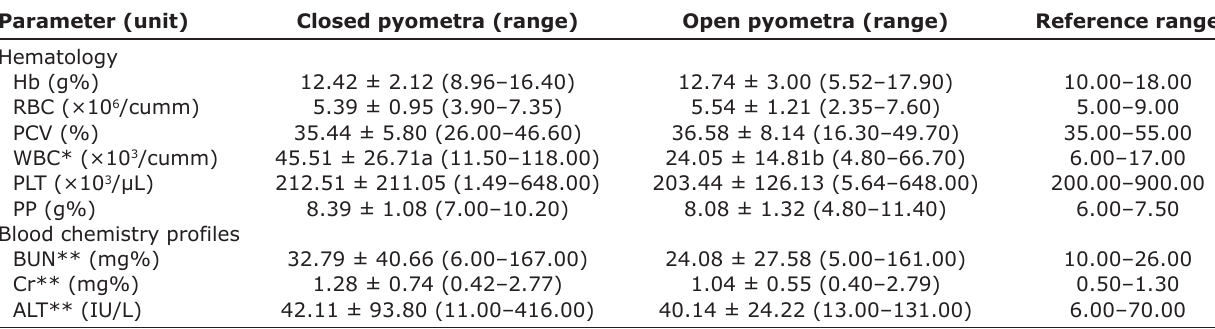
Table-7: Mean ± SD of hematology parameters and blood biochemistry levels of closed (n=19) and open (n=41) pyometra groups. Parameter (unit)